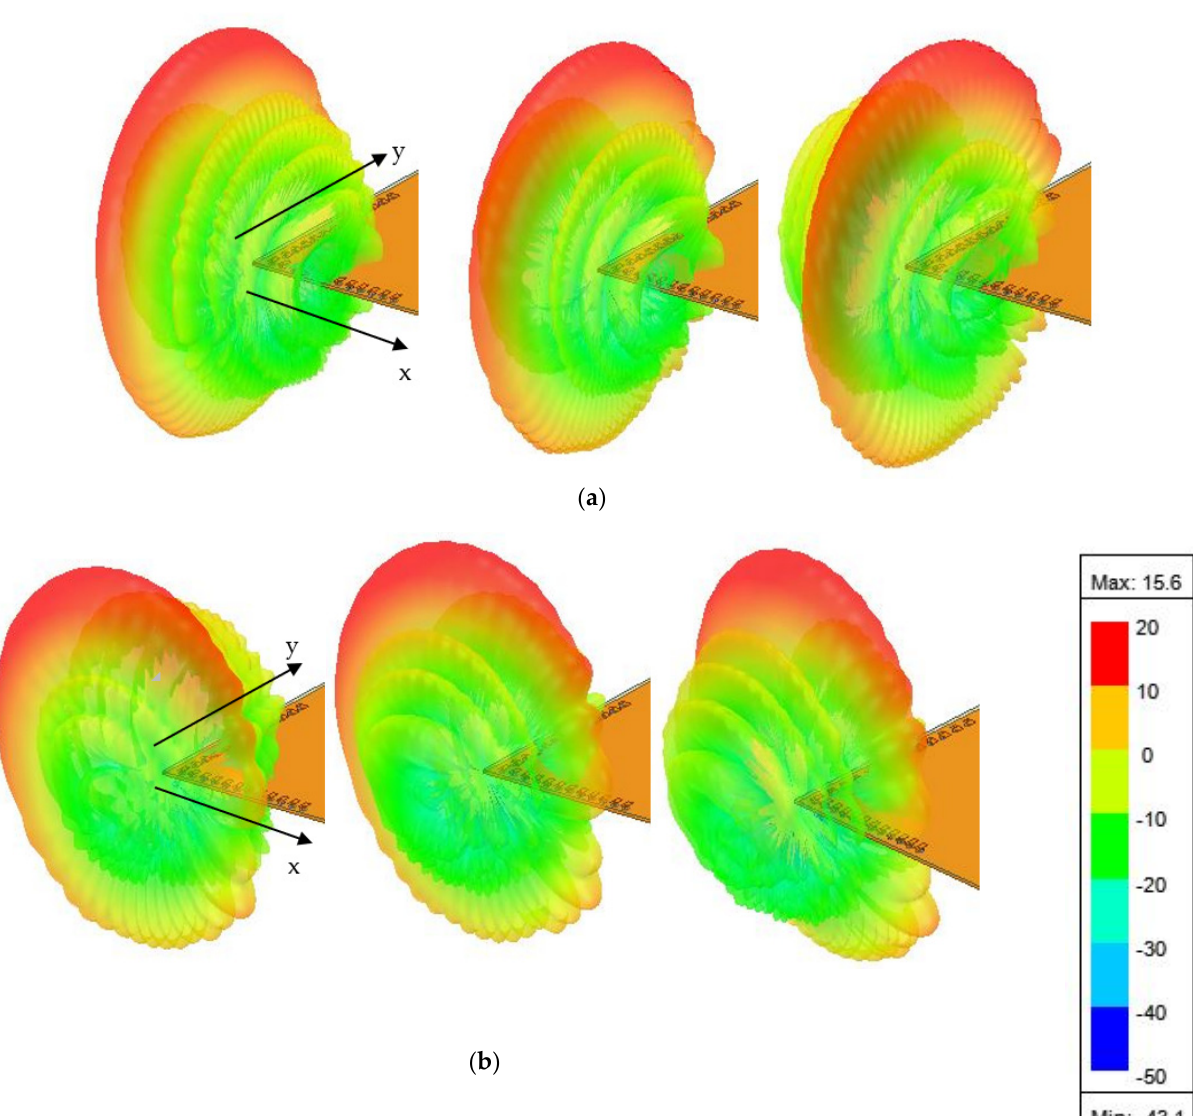
Figure 4. Simulated 3D radiation patterns for − 30 ◦ , 0 ◦ , and 30 ◦ scanning angles: ( a ) when the x − axis − oriented array is excited and ( b ) when the y − axis − oriented array is excited.